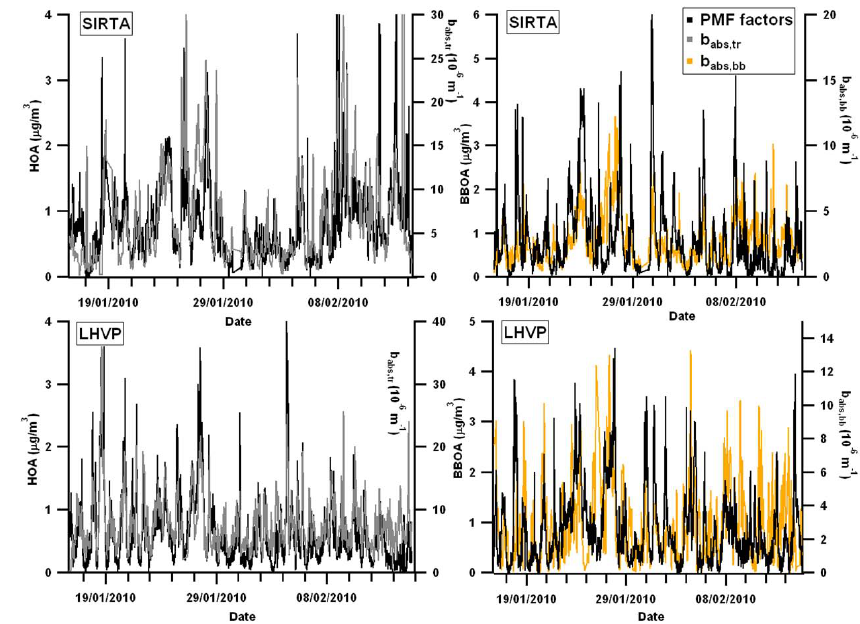
Fig. 10. Time series comparison of AMS and BC factors related to traffic and wood burning at the SIRTA and LHVP sites.